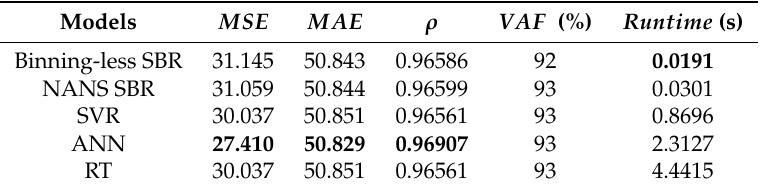
Table 1. Comparison on modeling a polynomial dependency: Mean squared error ( MSE ), mean absolute error ( MAE ), coefficient of correlation ( ρ ), variance-accounted-for ( VAF ) and runtime for the five considered modeling techniques (numerical-algebraic neural-system based statistical bivariate numerical modeling algorithm, proposed binning-less statistical bivariate numerical modeling algorithm, artificial neural network, support vector regression and random trees). Highlighted values denote the best figures per index.